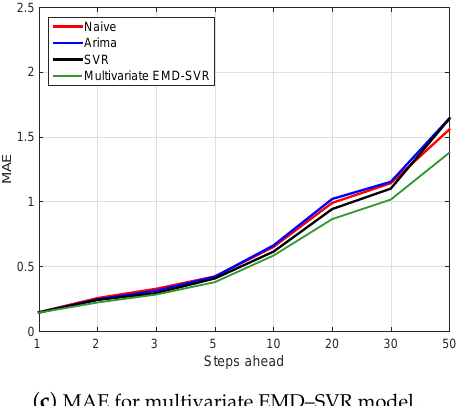
( c ) MAE for multivariate EMD–SVR model. Figure A2. Mean absolute error (MAE) as a function of the forecast horizon for the considered forecasting models: naive, autoregressive integrated moving average (ARIMA ( p , d , q ) ), univariate and multivariate empirical mode decomposition–support vector regression (EMD–SVR) with input vector m = 5 lagged values. Table A3. Z-statistic for the Wilcoxon signed-rank test for the null hypothesis that the naive model is as accurate as the studied models: autoregressive integrated moving average (ARIMA ( p , d , q ) ), and univariate and multivariate empirical mode decomposition–support vector regression (EMD–SVR) with input vector m = 1. Top: direct strategy; bottom: recursive strategy. * Statistically significant at the 5% confidence level. ** Statistically significant at the 1% confidence level.